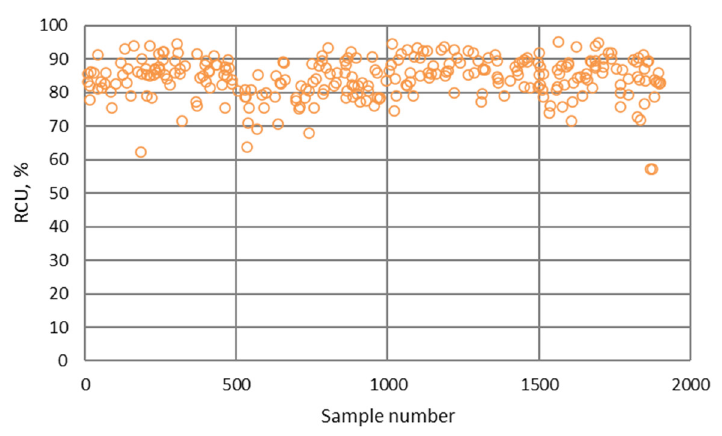
Figure A34. NN2 model—testing dataset.